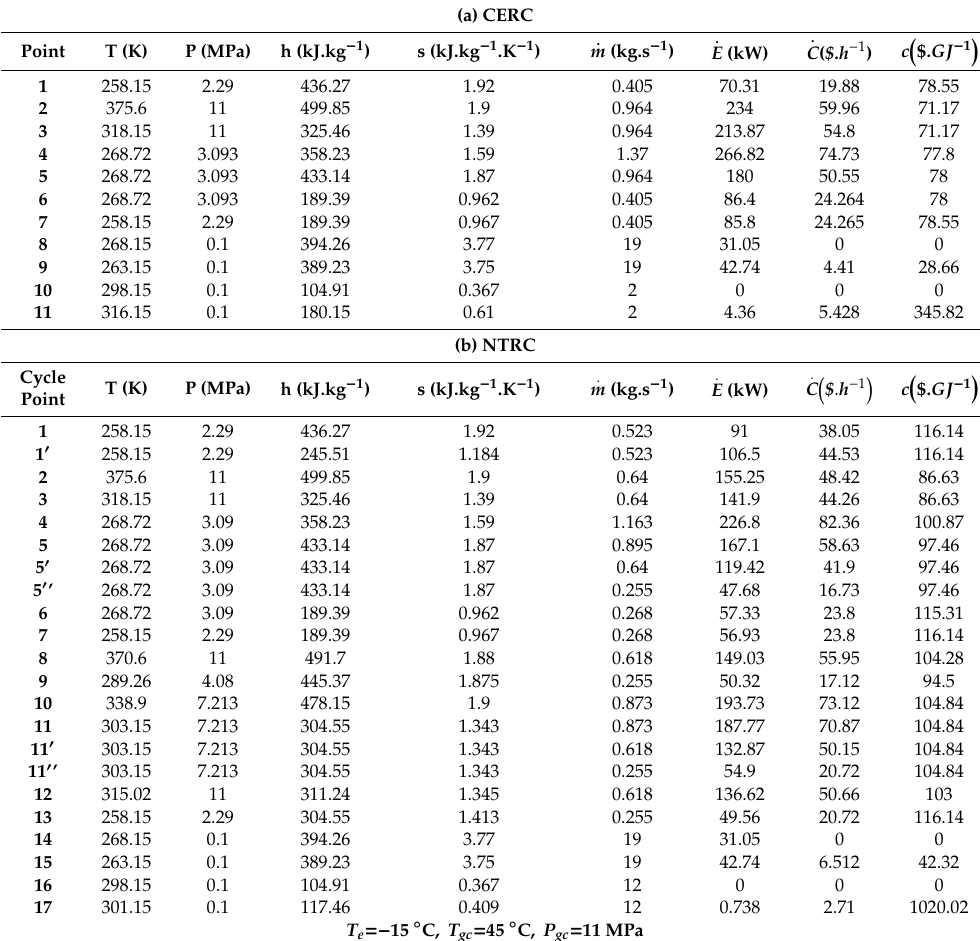
Table 7. CERC and NTRC points’ properties and rates of cost.